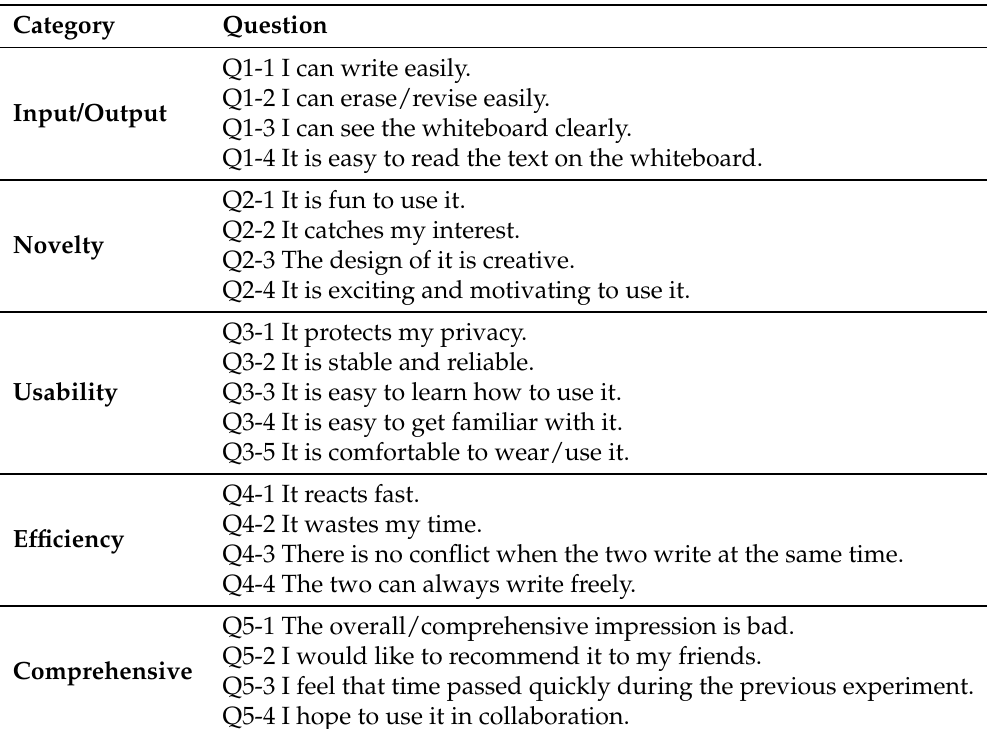
Table 5. List of categories and specific questions of the user experience survey scale (question- naire) regarding the traditional whiteboard (pen), electronic whiteboard (mouse), and the proposed VR